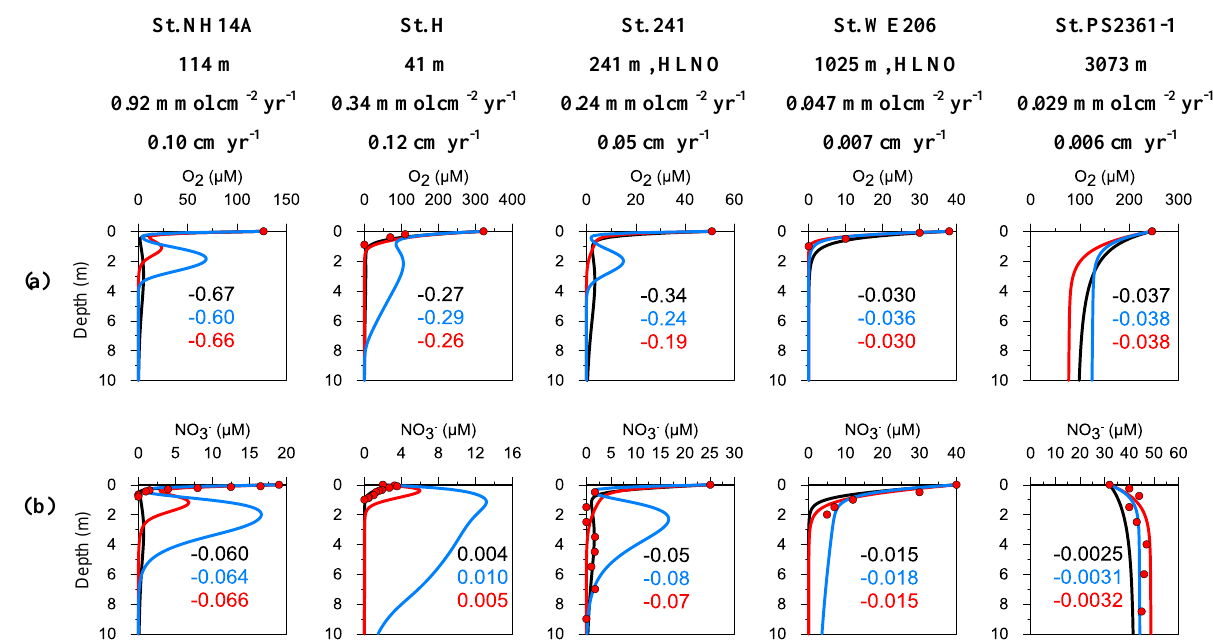
Figure 4. (a) O 2 and (b) NO − concentrations in the bioturbated layer for marine settings with different water depths, POC rain rates and 3 sedimentation rates (listed above the plots). Black curves show the model predictions with the power function (Stolpovsky et al., 2015), red curves (this study) denote the 3-G model, blue curves show results using 2-G approach, and the symbols are the measured data. The numbers on each panel indicate the corresponding fluxes in mmolcm − 2 yr − 1 . References for stations (see Table S1 in Supplement in Stolpovsky et al., 2015): St. NH14A = Washington margin (Devol and Christensen, 1993), St. H = Arctic shelf (Devol et al., 1997), St. 241 = Mauritanian margin (Dale et al., 2014), St. WE206 = Washington margin (Hartnett and Devol, 2003), St. PS2361-1 = Southern Ocean (Smetacek et al.,